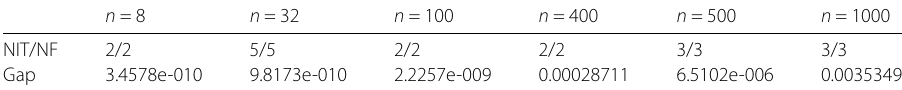
Table 2 Numerical results of Example